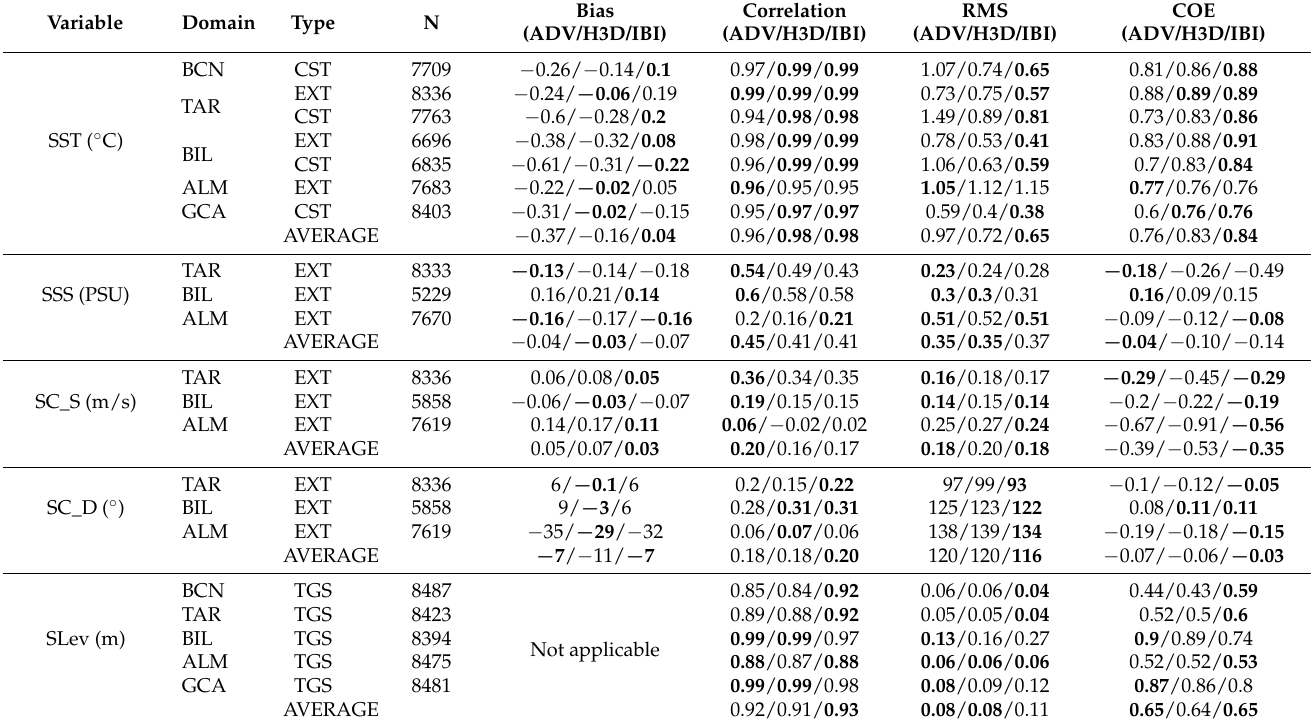
Table 4. Error metrics for the SAMOA SAM_H3D and SAM_ADV test runs, plus the IBI_PHY parent solution (computed with hourly observations). The metrics comprise the time range from October 2019 to October 2020. Variables: SST (Sea Surface Temperature in ◦ C), SSS (Sea Surface Salinity, in PSU), SC_S (Surface current speed, in m/s), SC_D (Surface current direction, in ◦ ), SLev (sea level, in m). The domain column identifies the SAMOA system. The Type denotes the sensor type used: TGS (Tide Gauge Station), CST (Coastal Buoy), EXT (Deep-water buoy). N counts the size of the sample (conditioned by the availability of hourly observation). Each error metric (Bias, Correlation, Root-Mean-Square Error (RMS) and Coefficient of Efficiency (COE)) provided for each model solution (SAM_ADV (ADV), SAM_H3D (H3D) and IBI_PHY(IBI)). The last row of each variable represents the average error metric of all the sensors given a specific test run. Bold numbers highlight the best performing